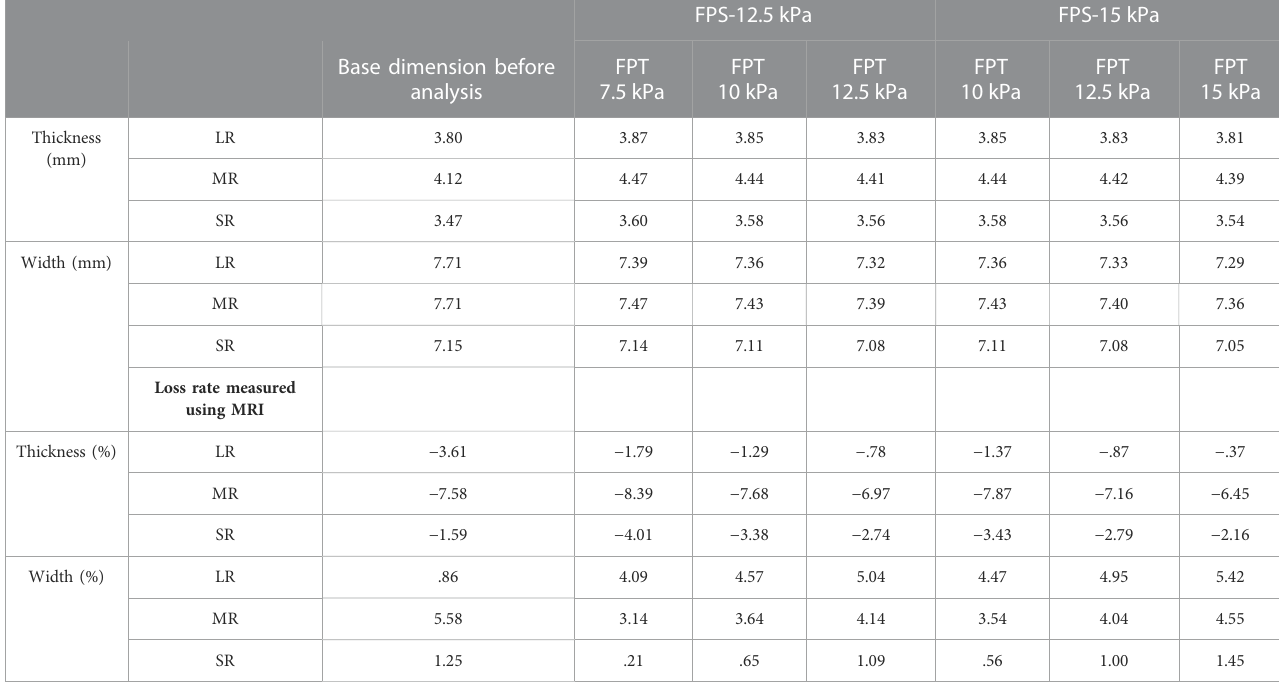
TABLE 4 Muscle loss rate in fi nite element analysis of inferior rectus (IR) muscle hypertrophy and the elevated IOP (based on FPE of 300